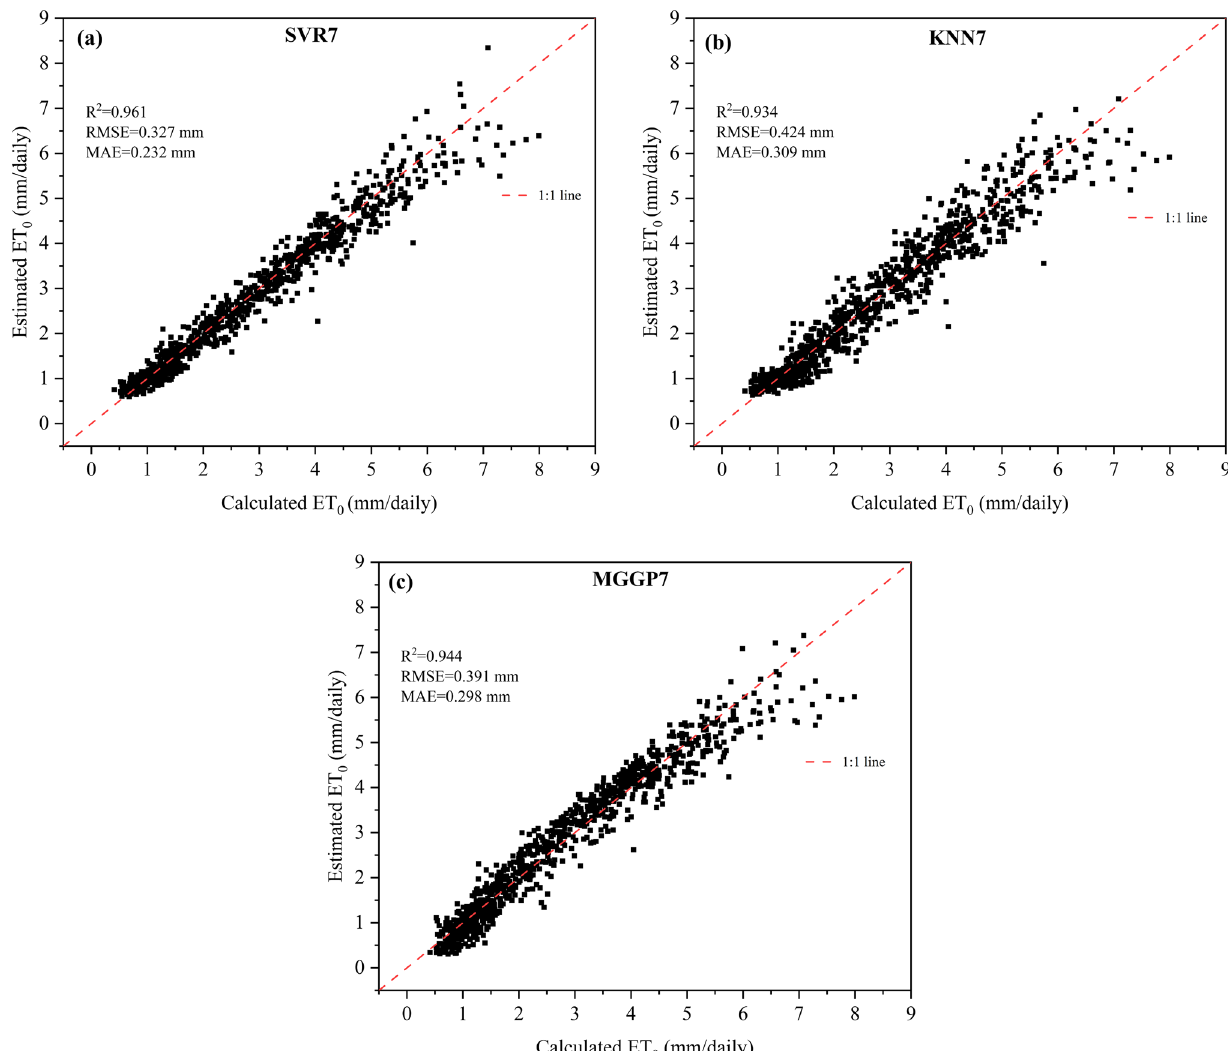
Fig. 4 Scatter charts of a SVR7, b KNN7, and c MGGP7